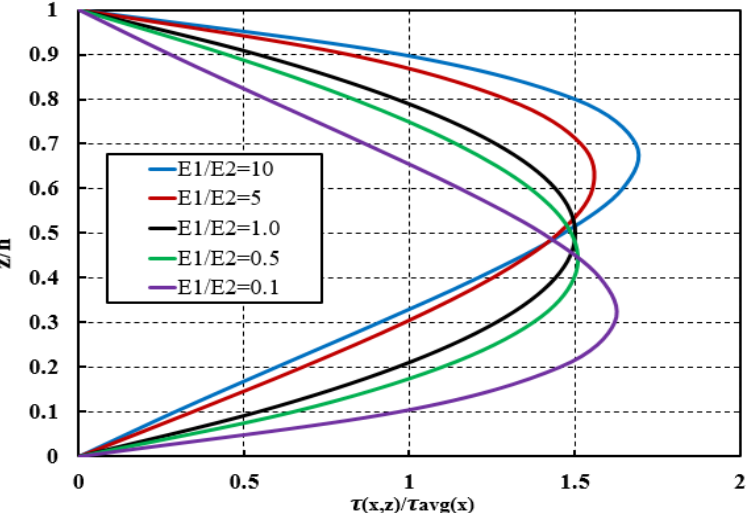
Figure 4. Normalized Shear stress τ xz distribution in simply supported E-FGM beam.